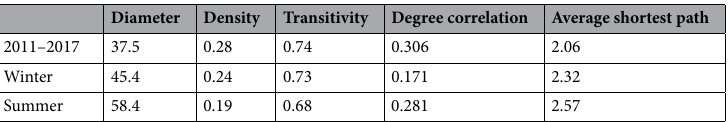
Table 1. Network metrics for the three networks representing the average connectivity during the entire period 2011–2017, and the summer and winter